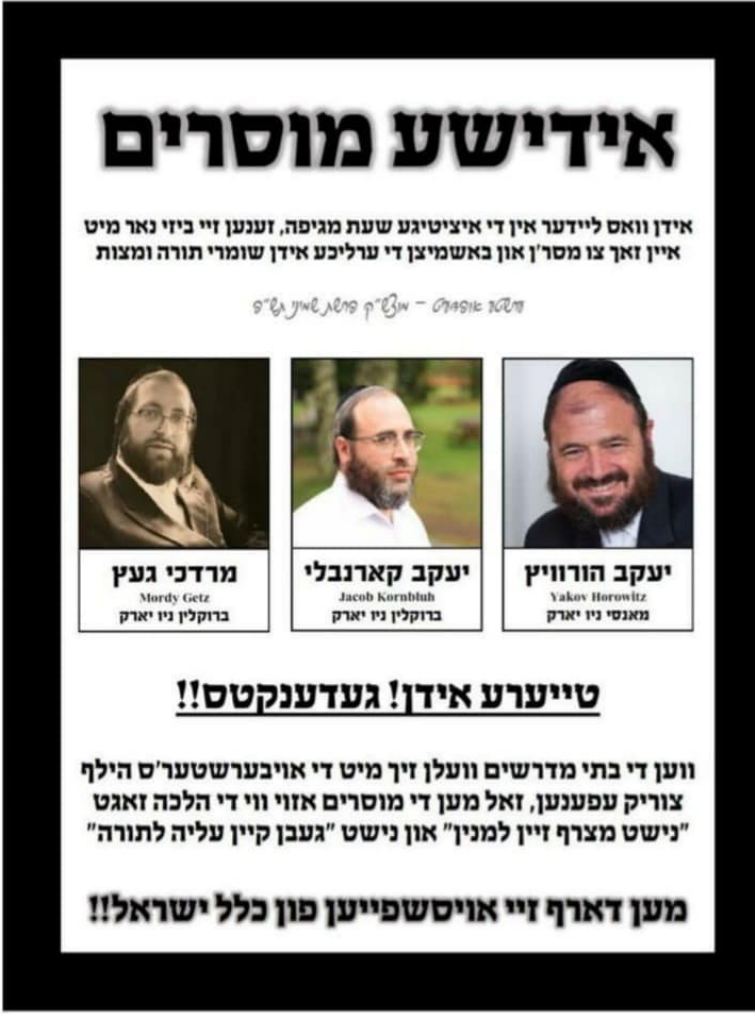
Figure 2. “Jewish Turncoats”. A poster that displays the images of Jewish men who are considered “turncoats” (Source : https://www.lohud.com/story/news/local/rockland/2020/04/20/social-distancing-prayer-gatherings-orthodox-jewish-community/5164417002/, accessed on 24 August 2021).